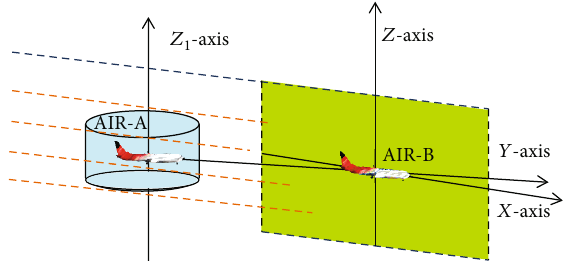
Figure 1: The collision box laterally traverses the spacer